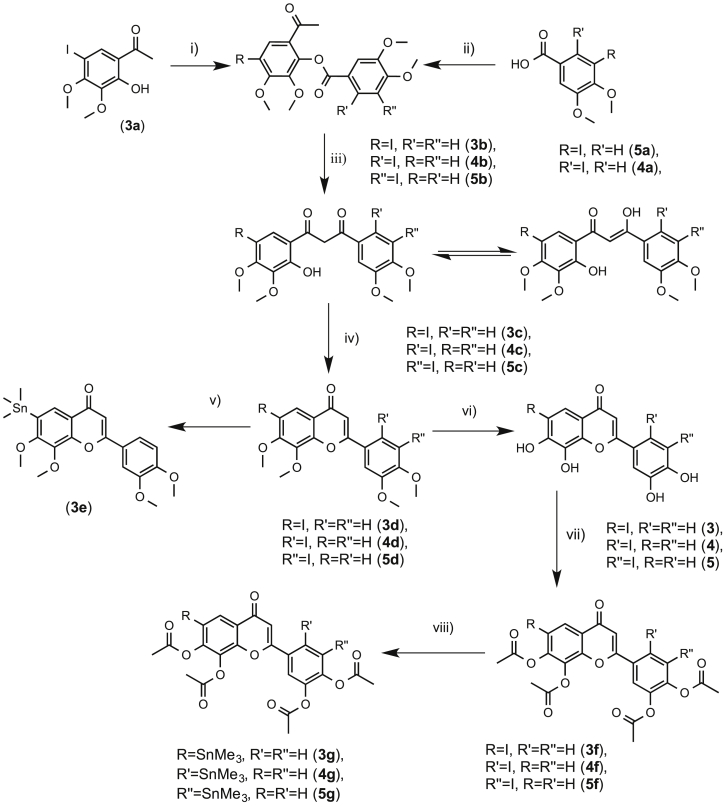
i) 3,4-dimethoxybenzoyl chloride, pyridine, 2 h, r.t.; ii) a) oxalyl chloride, DMF, DCM, 2 h 0 °C, b) 3,4-dimethoxy-2-hydroxyacetophenone, pyridine, DCM, 2 h, r.t.; iii) KOH, pyridine, 1 h, 50 °C; iv) NaOAc, AcOH, 2 h, 120 °C; v) Sn2Me6, PdCl2(PPh3)2, 1,4-dioxane, 1.5 h, 60 °C; vi) BBr3, DCM, 2 h, 0 °C – r.t.; vii) Ac2O, pyridine, 20 h, 45 °C; viii) Sn2Me6, PdCl2(PPh3)2, 1,4-dioxane, 1.5 h, 60 °C.